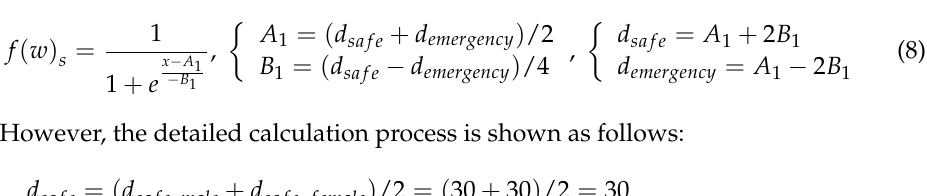
Figure 8. The relative distance division in the process of car-following.